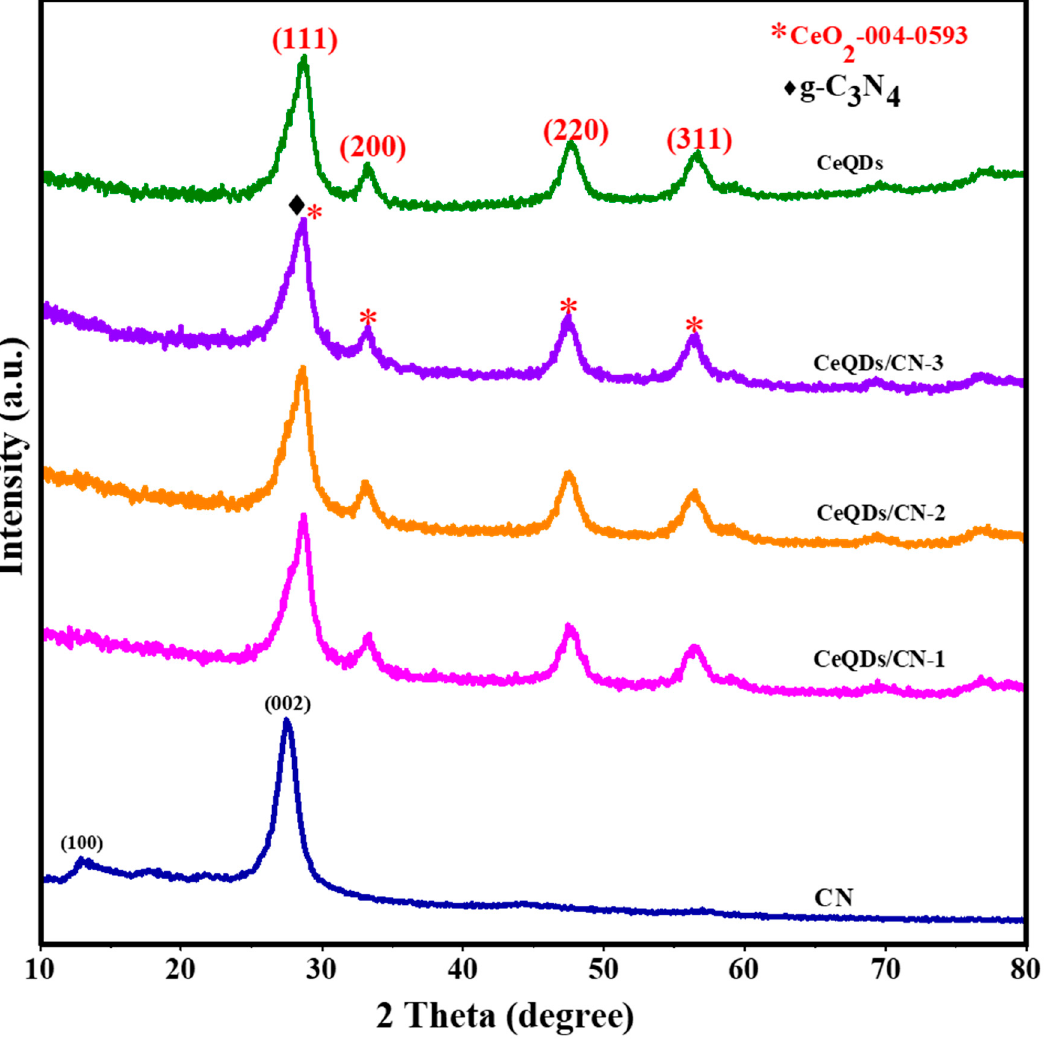
Figure 1. XRD pattern of the CN, CeQDs, CeQDs/CN-1, CeQDs/CN-2, and CeQDs/CN-3 nanostruc- tures.